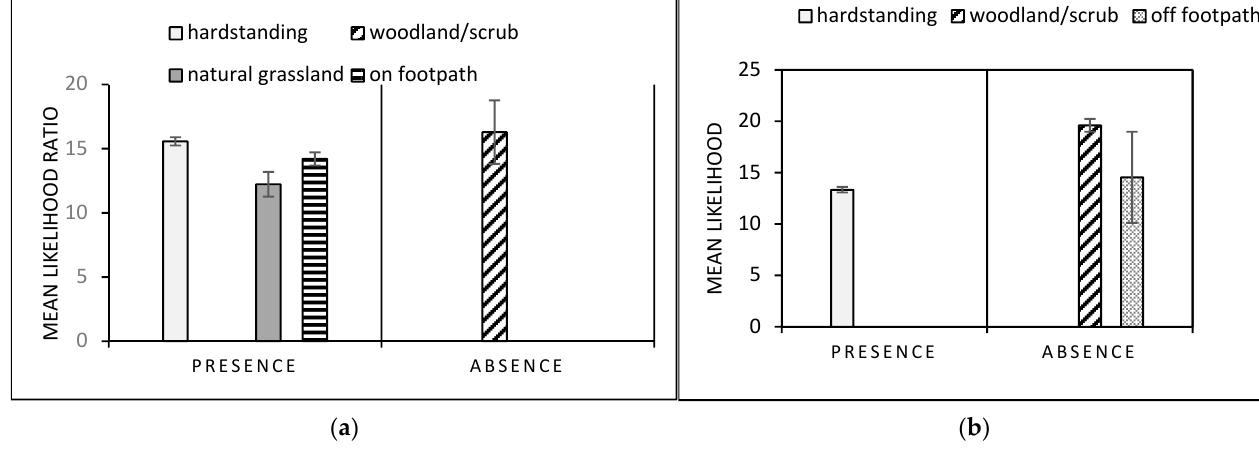
Figure 5. Mean likelihood ratios, ±standard error, from conditional probability trees where conditional probabilities were >10 times magnitude for dog ( Canis lupus familiaris ) presence and absence during the: ( a ) morning (06.30–10.30) and ( b ) day (12.30–16.00). Data were derived from point count transect data across 7 study sites in Brighton and Hove and surrounding areas, England, UK.